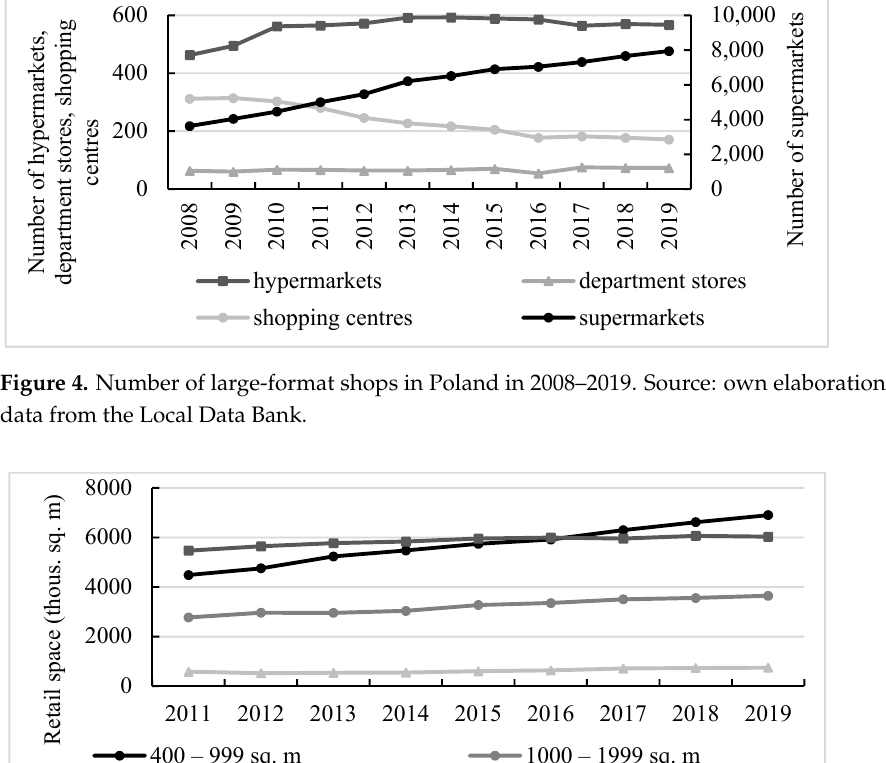
Figure 4. Number of large-format shops in Poland in 2008–2019. Source: own elaboration based on data from the Local Data Bank. Figure 5. Retail space in Poland in 2011–2019 (as of December 31st). Source: own elaboration based on data from the Local Data Bank.